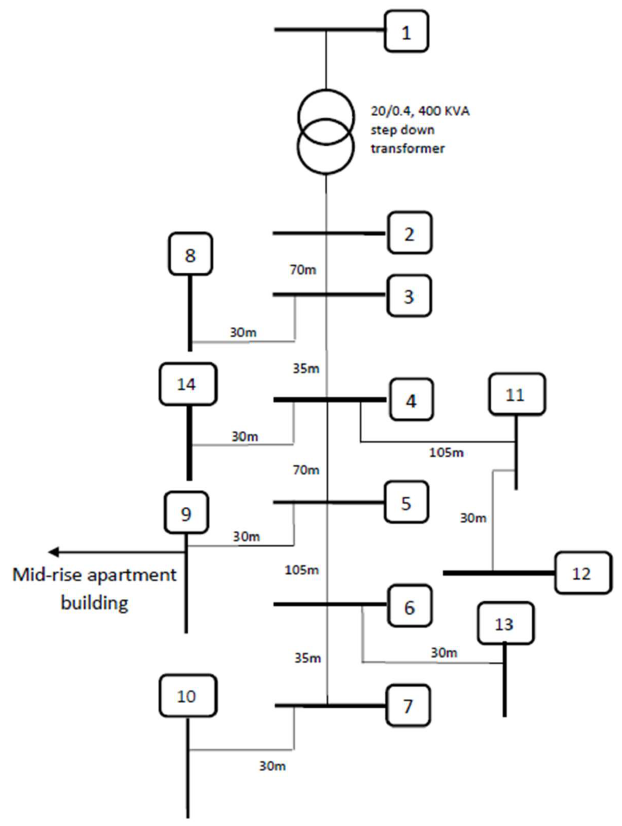
Figure 3. 14-bus microgrid connecting mid-rise apartments (all of the bus connection cable lengths are in meters)